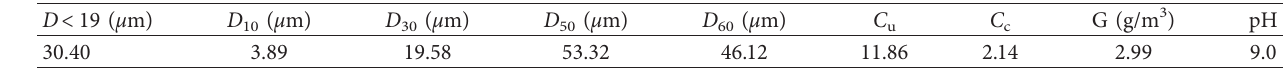
Table 2: Physical properties of tailings in XTM.